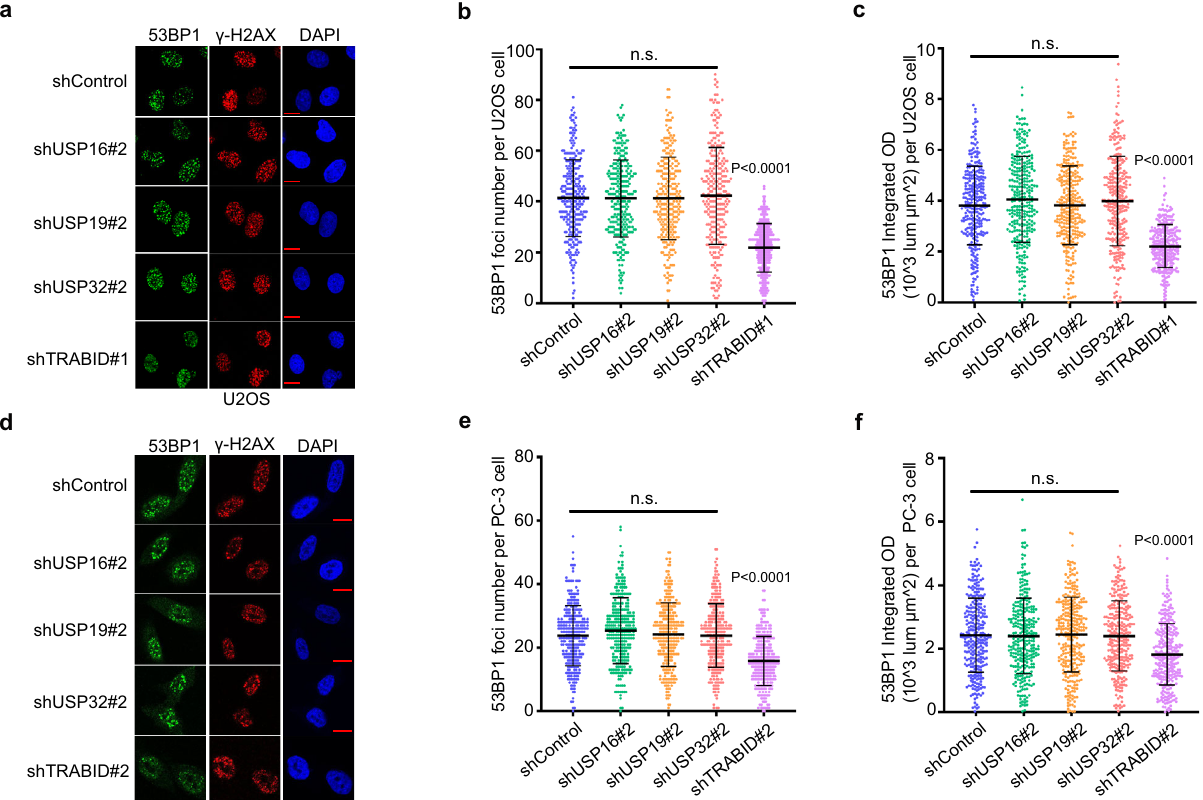
Fig.1|TRABIDregulates53BP1fociformationatDSBsites. U2OS( a – c )andPC-3 ( d – f ) cells infected with lentivirus expressing control shRNAs (shControl) or shRNAsspeci fi cforindicatedgenesweretreatedwithIRandsubjectedto53BP1IFC 1hpost-treatment( a , d ).Scalebar,10 µ m.Theaverage53BP1focinumber( b , e )and focidensity( c , f )ineachcellwerequanti fi